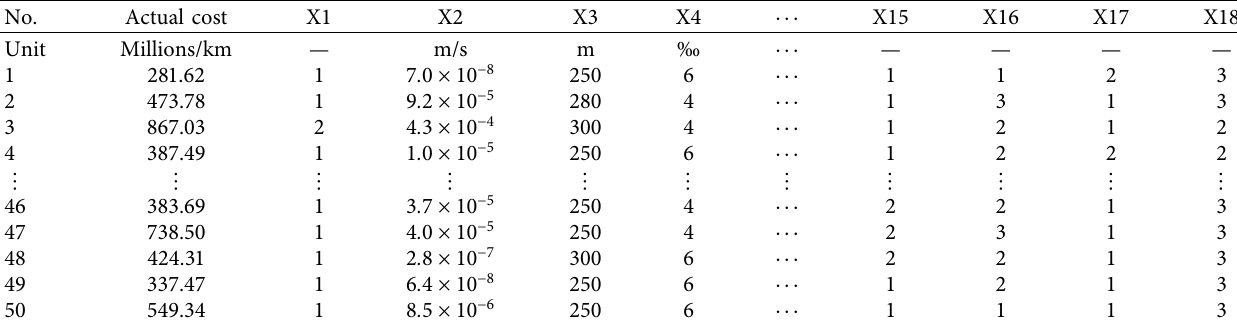
Table 1: Scores of the indices and the actual construction cost.